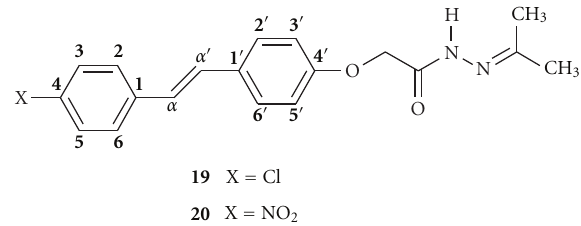
F 2: e structures of compounds 19 and 20 .